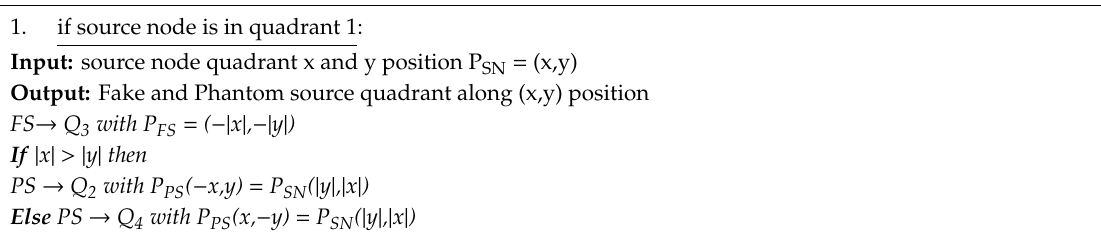
Algorithm 2, for selection of fake and phantom source for di ff erent scenarios of real source places other than inside blast